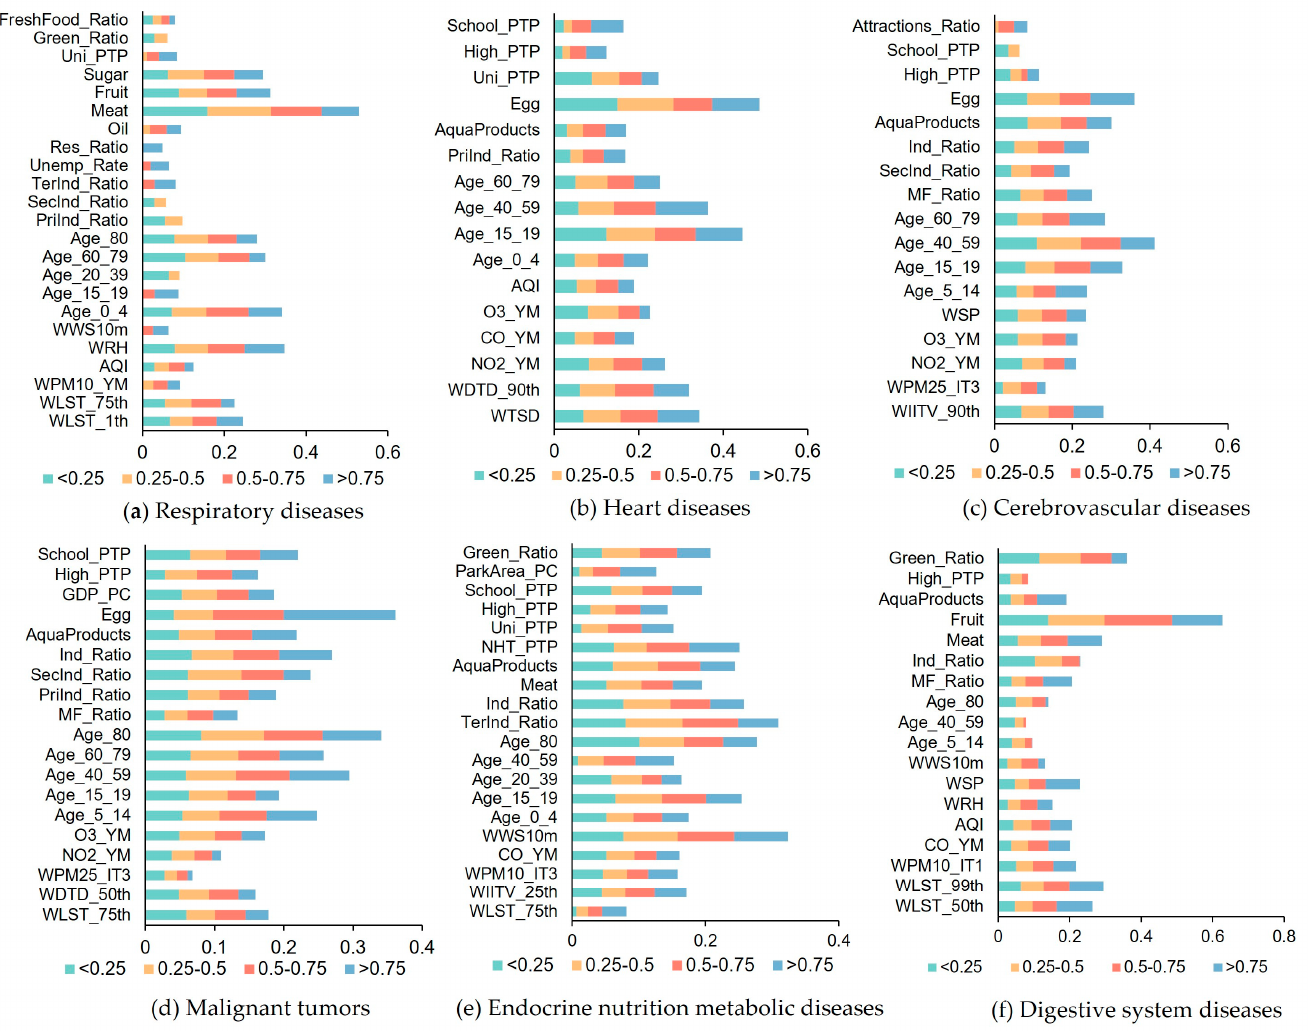
Figure 4. Distribution of indicators and weights obtained by quantile regression related to the six kinds of chronic diseases studied. Di ff erent colors indicate the index weights corresponding to different quantile levels (<0.25, 0.25–0.5, 0.5–0.75, >0.75) of mortality rates.